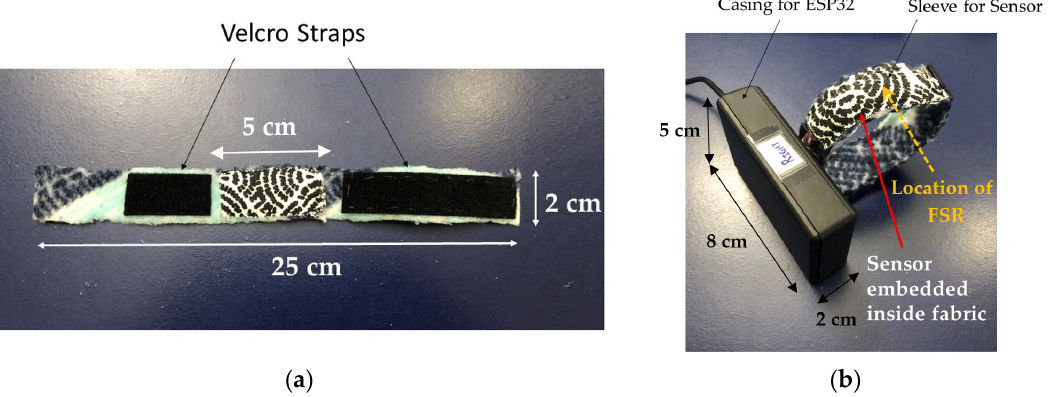
Figure 2. ( a ) Armband prototype with embedded FSR; ( b ) wearable sensor showing the casing for the ESP32 and the wristband with the FSR.